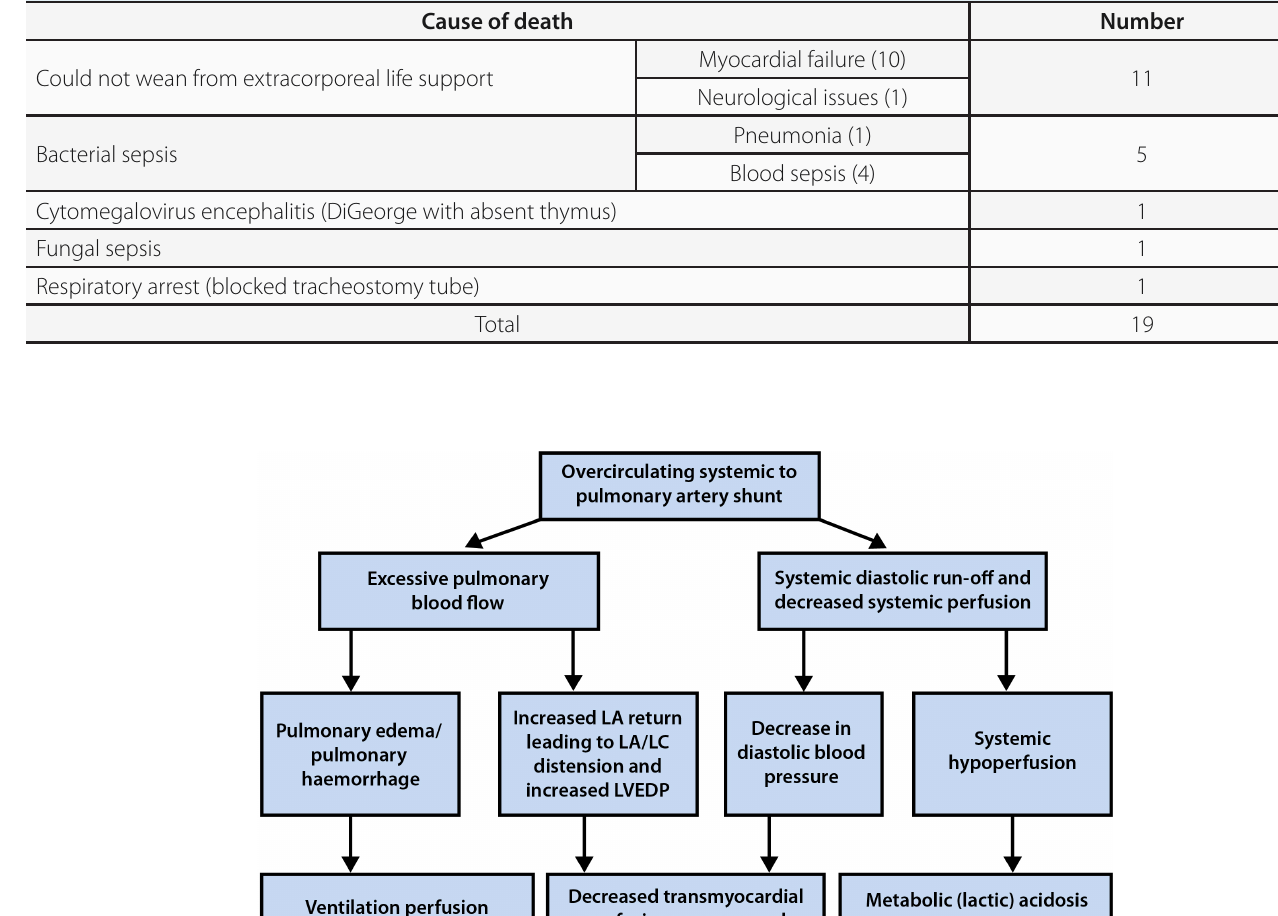
Table 1. Patients’ cause of death.